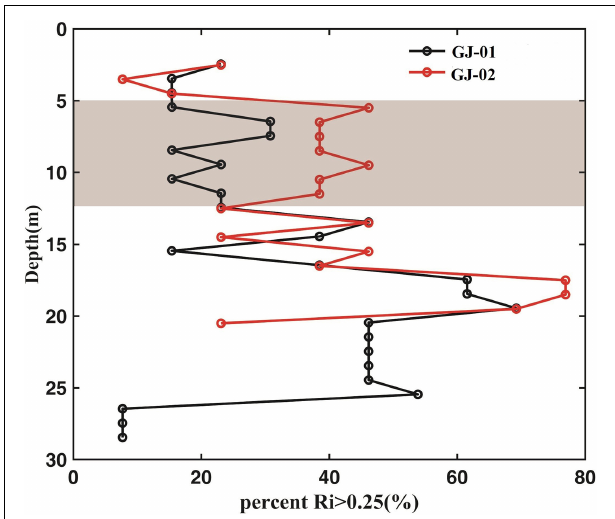
FIGURE 13 | The proportion of the time having Ri g > 0.25 is plotted vs. the water depth for GJ-01 (black line) and GJ-02 (red line). The statistics are obtained according to individual hourly-observation